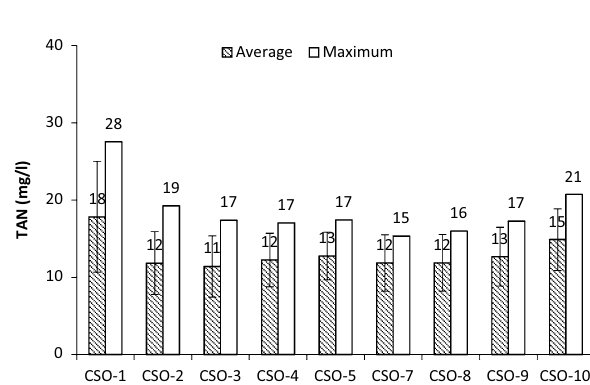
Fig. 5 Average (over the sampling period) and maximum concen- trations of total ammonia nitrogen (TAN, mg/l), at the 9 sampling locations located close to the 9 CSO